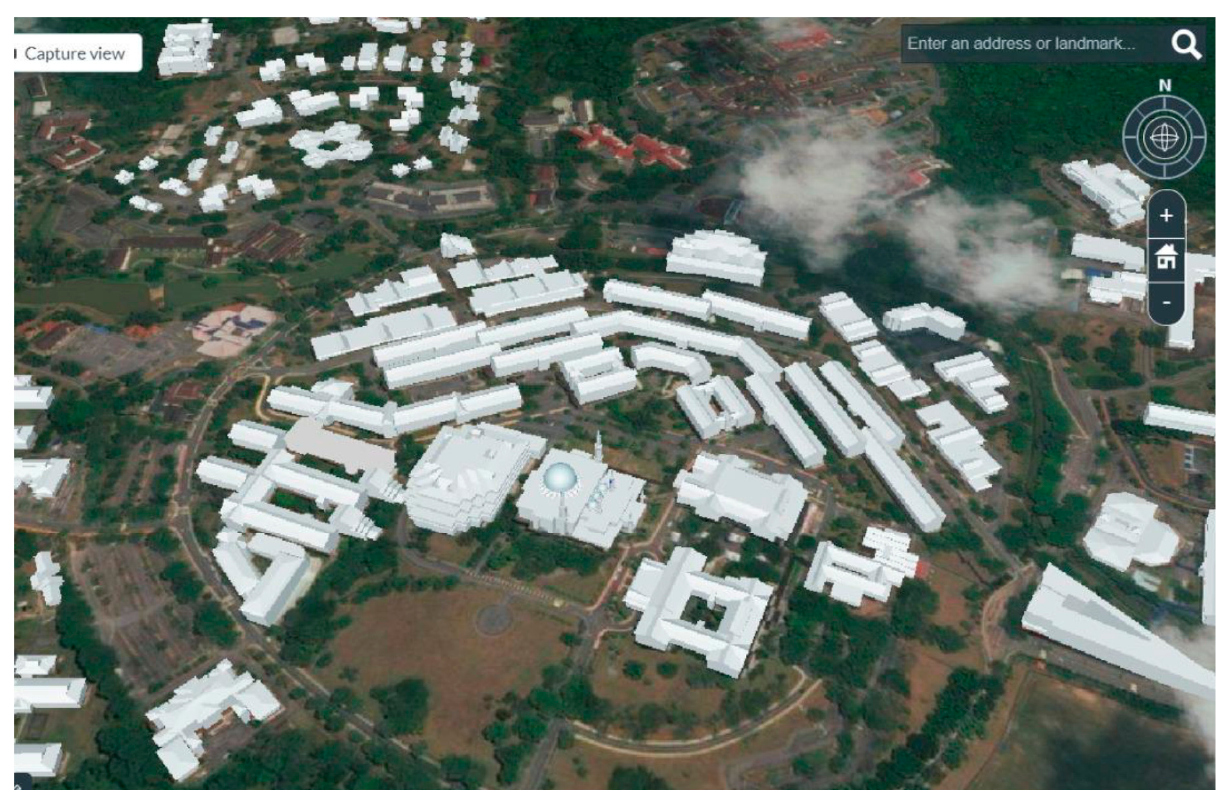
Figure 12. Virtual 3D of Universiti Teknologi Malaysia campus with 381 buildings as displayed using FZK Viewer.